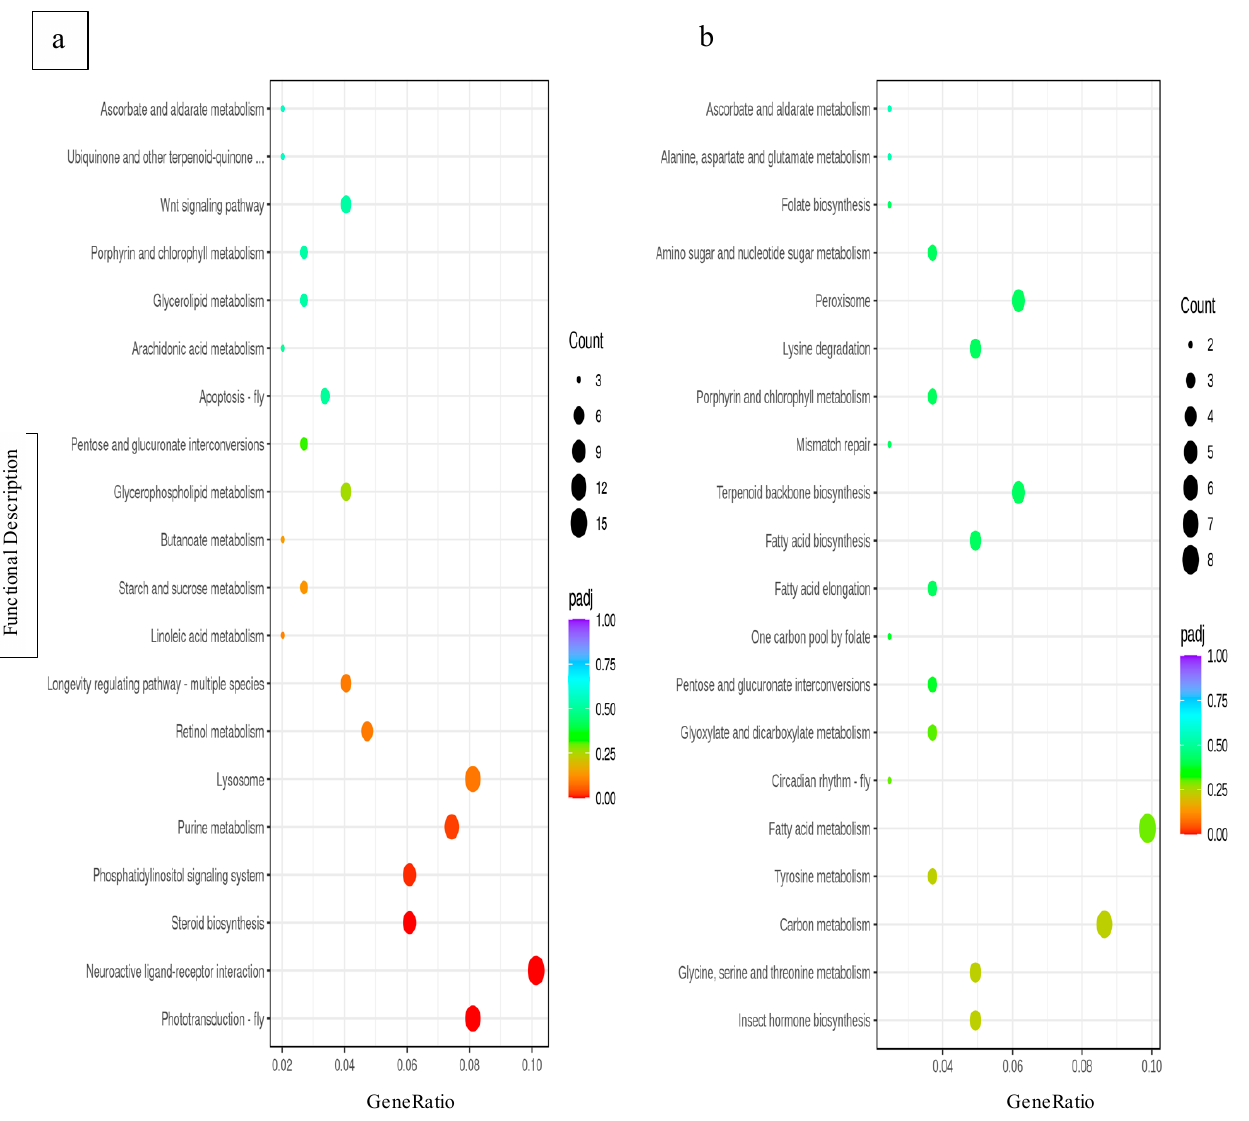
Figure 6. Dot plot of KEGG pathway enrichment analysis of up ( a ) and down ( b ) regulated differentially expressed genes. Gene ratio is the percentage of differentially expressed genes in each term. Diameter of circles represents the relative number of genes within each functional gene identity. Larger diameter represents a greater number of counts, and smaller diameter circles represent lower numbers of counts. Color of the circles represents the adjusted p -value (padj) of the gene identities, with a lower p value being represented in red and higher p -value represented by violet.